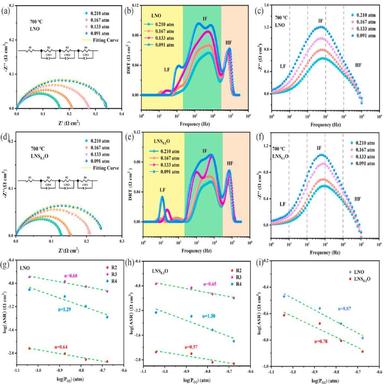
(a) EIS curve, (b) corresponding DRT curve, and (c) Bode curve of LNO under different PO2 at 700 ◦C. (d) EIS curve of LNS0.1O under the same conditions and (e) corresponding DRT curve and (f) Bode curve. (g ~ i) R2, R3, R4 and Rp rate-limiting steps of LNO and LNS0.1O.